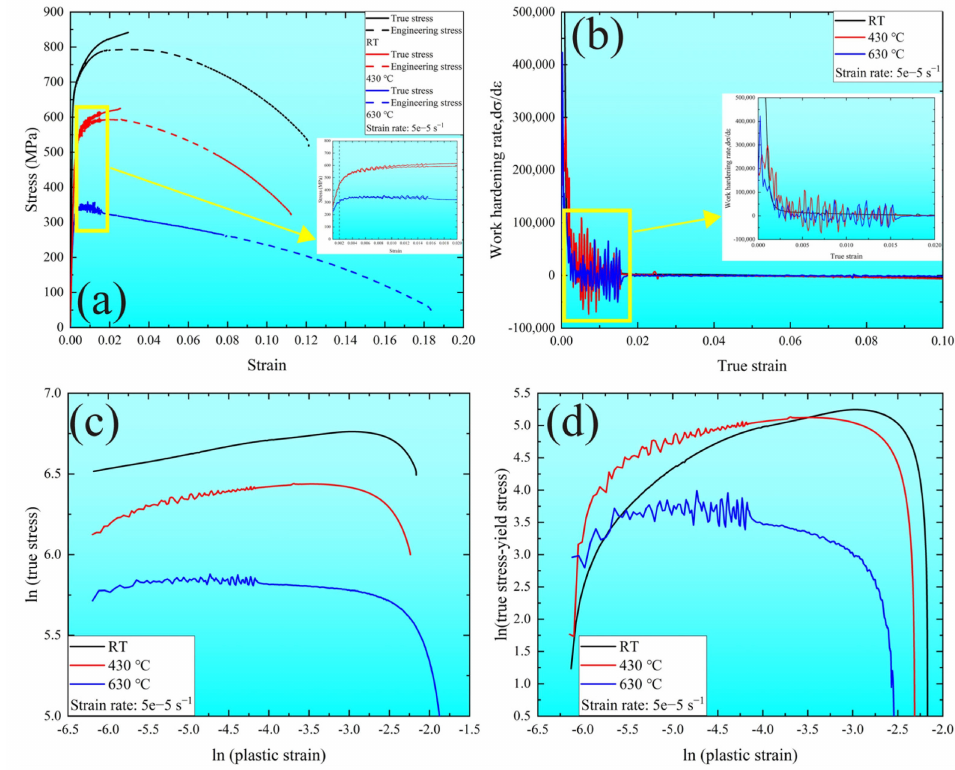
Figure 3. The tensile behavior at a strain rate of 5 × 10 − 5 s − 1 at RT, 430 ◦ C, and 630 ◦ C: ( a ) The stress–strain curves; ( b ) the work hardening rate curves; and the strain hardening exponent using ( c ) Equation (1) and ( d ) Equation (2). Table 1. Detailed tensile properties under different temperatures at a strain rate of 5 × 10 − 5 . Strain Rates/s − 1 Temperature/ ◦ C Yield Strength/MPa Tensile